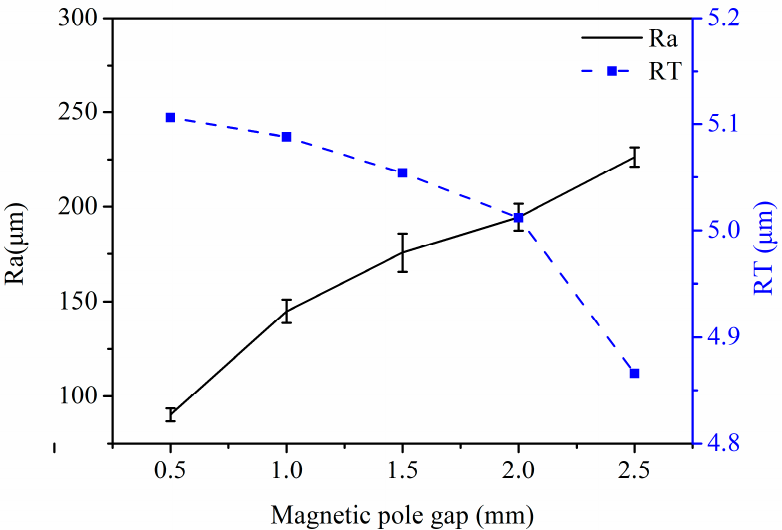
Figure 11. Graph of the effect of magnetic pole gap on Ra and RT of tube inner wall.